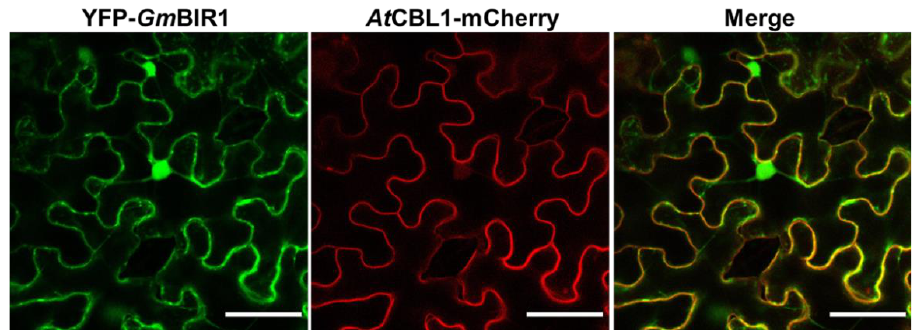
Figure 6. The subcelluar localization of GFP- Gm BIR1. The GFP- Gm BIR1 localizes both at plasma membrane (PM) and in the nucleus. The PM-localized protein At CBL1-mCherry was used as a control. Bar = 5 0 μm. This experiment was repeated 3 times with similar result s.